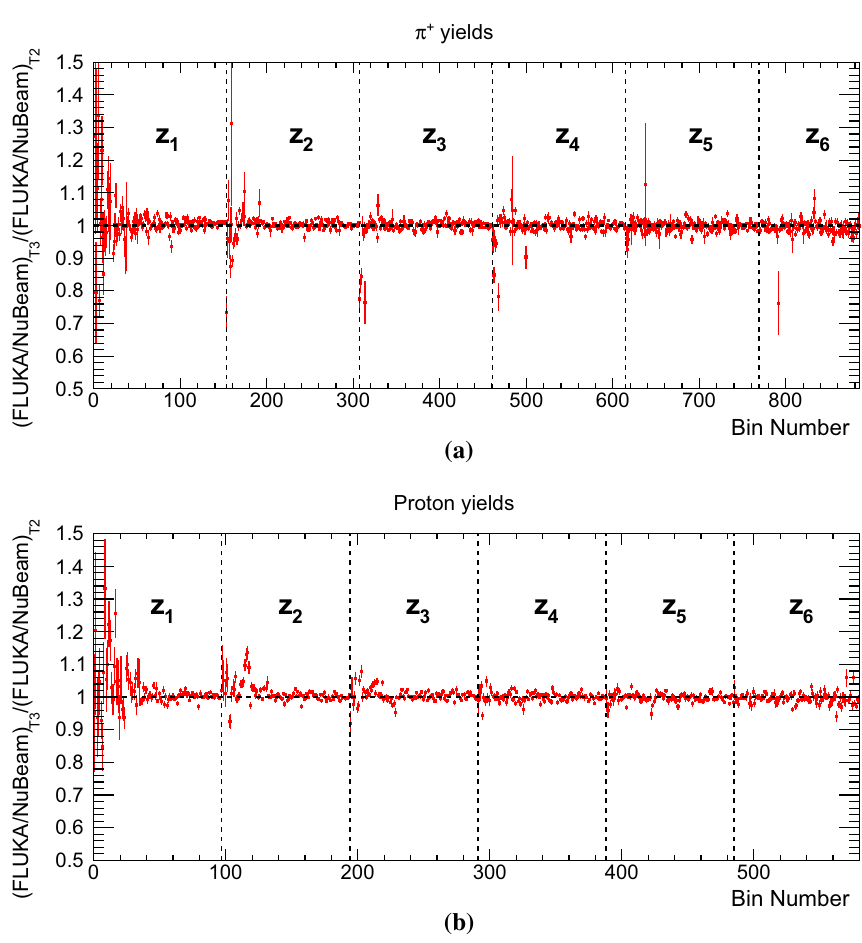
Fig. 55 Ratio of the simulated re-weighting factors produced with the T 2 and T 3 beam profiles for positively charged pions ( a ) and protons ( b